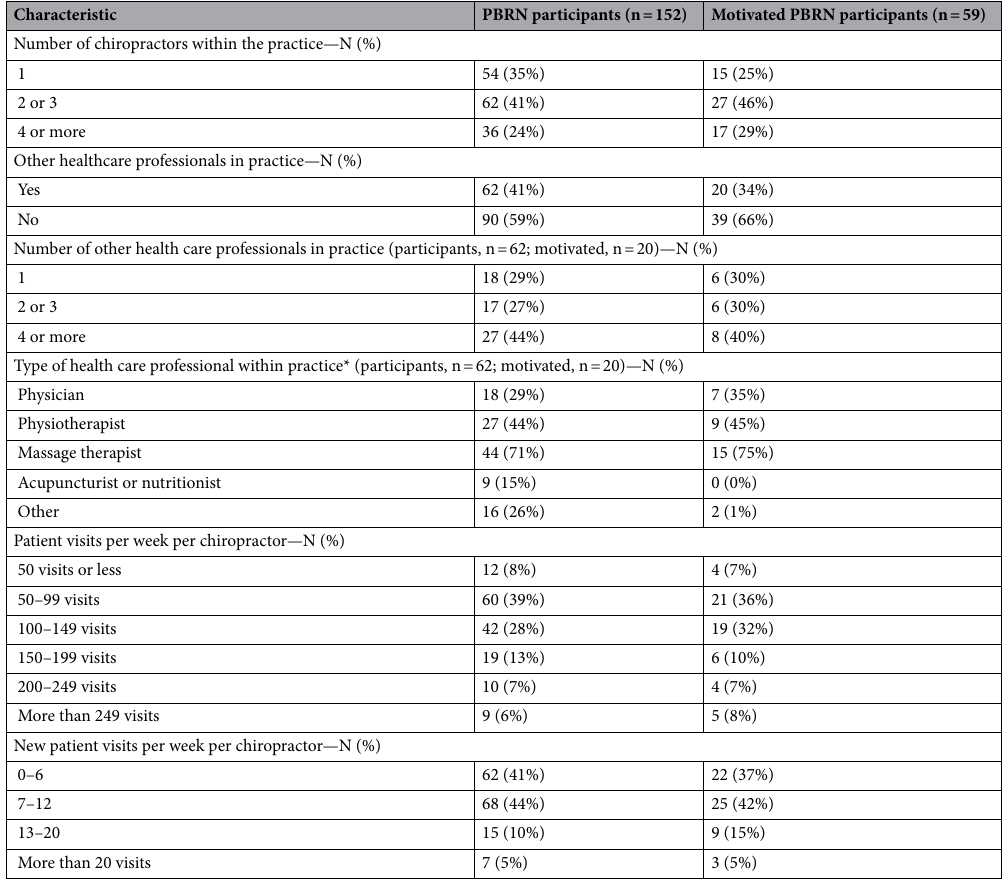
Table 2. Practice characteristics of all PBRN clinics and motivated PBRN clinics. n number. *Participants allowed to select more than one response option.